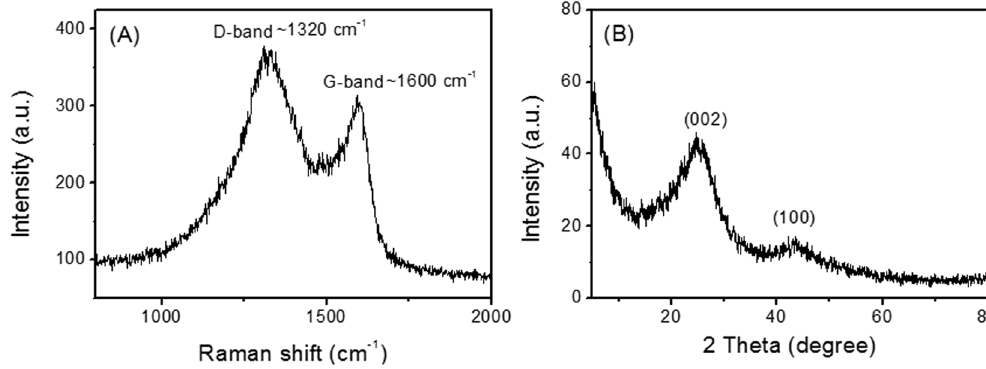
Figure 3. Raman spectroscopy ( A ) and XRD characteristic ( B ) of elastic carbon